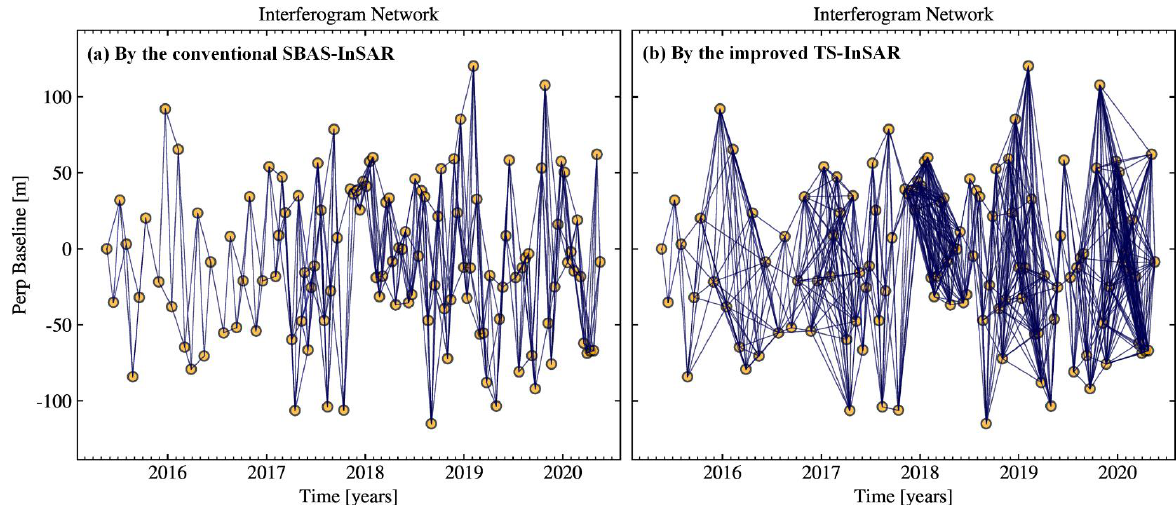
Figure 6. The spatiotemporal baselines of the interferograms for the conventional SBAS-InSAR and the improved TS-InSAR.